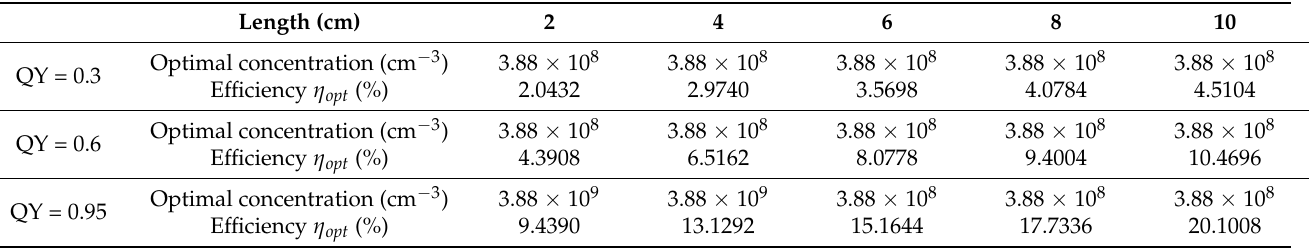
Figure 16. Optical efficiency concerning concentrations of nanoparticles in radii of 1, 3, and 5 cm with lengths of 2, 4, 6, 8, and 10 cm ( A – E ), respectively. Table 3. Optimal efficiencies for different lengths and optimal concentrations in a radius of 3 cm and quantum yields of 0.3, 0.6, and